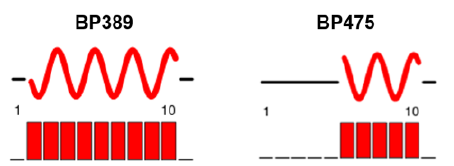
Figure 3. Secondary structure adopted by each peptide. Numbers indicate the position of the amino acids. The red curve represents an α -helix, while the black line stands for a random coil region.